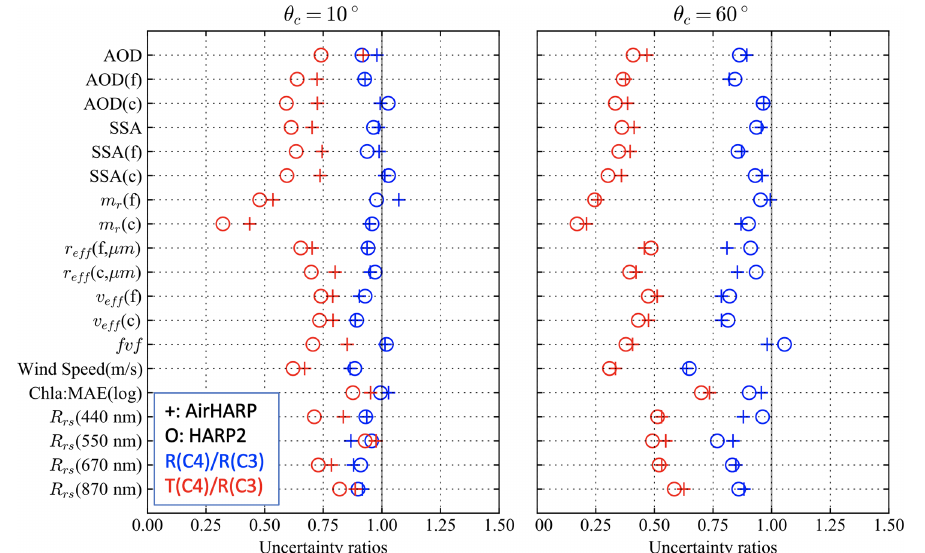
Figure 8. The ratio of real retrieval uncertainties between scenarios C4 and C3 as denoted in the legend by R( C4 )/R( C3 ) for AirHARP and HARP2 measurements with a correlation angle equal to 10 and 60 ◦ ; similarly, the real and theoretical uncertainties for C4 are compared with the real uncertainties for C3 denoted as T ( C4 )/R( C3 ) .